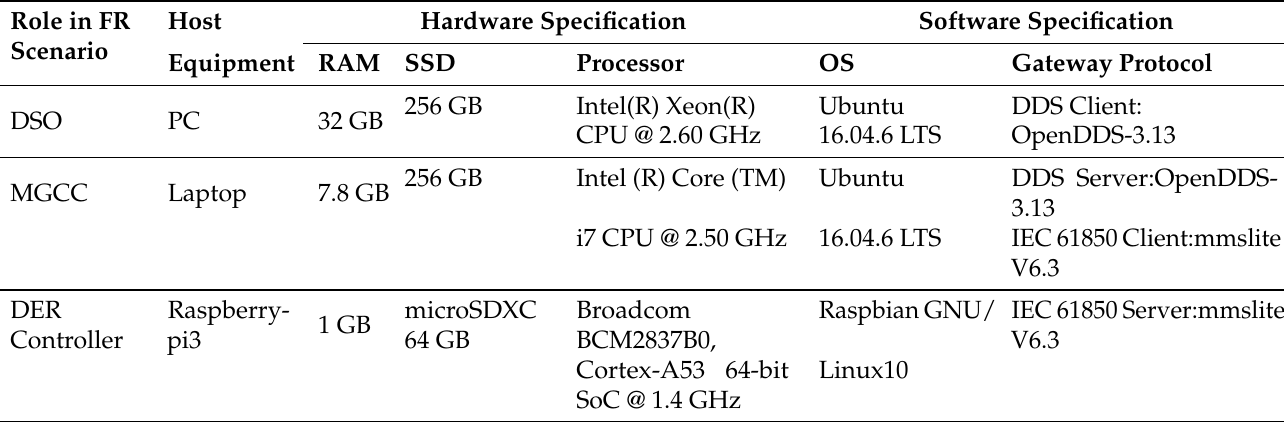
Figure 4. MG as FR-support network infrastructure (Experimental setup). The MG is arranged in the NGN Lab’s LAN, where DER controllers and MGCC are located. The WAN for interaction between MGCC and TSO/DSO is implemented through the Internet connection between NGN Lab and the Sejong University server room. Table 4. Specification of experimental network infrastructure for MG as FR-support according to IEC 61850 standard. Role in